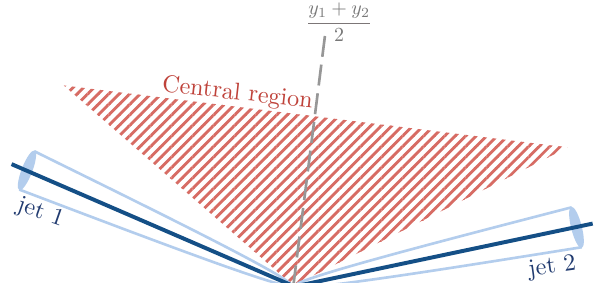
Fig. 3 Illustrationofthecentralregionusedtocountleptonsandjetsin the definition of the signal, control, and validation regions. The rapidity range of the region corresponds to C max = 0 . 4 in Eq. (2). An object in the direction of the dashed line has C = 0